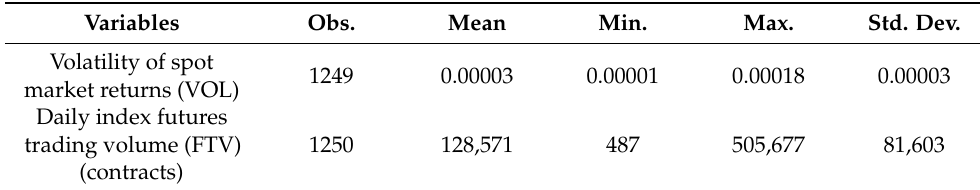
Table 2. Summary statistics of the sample.